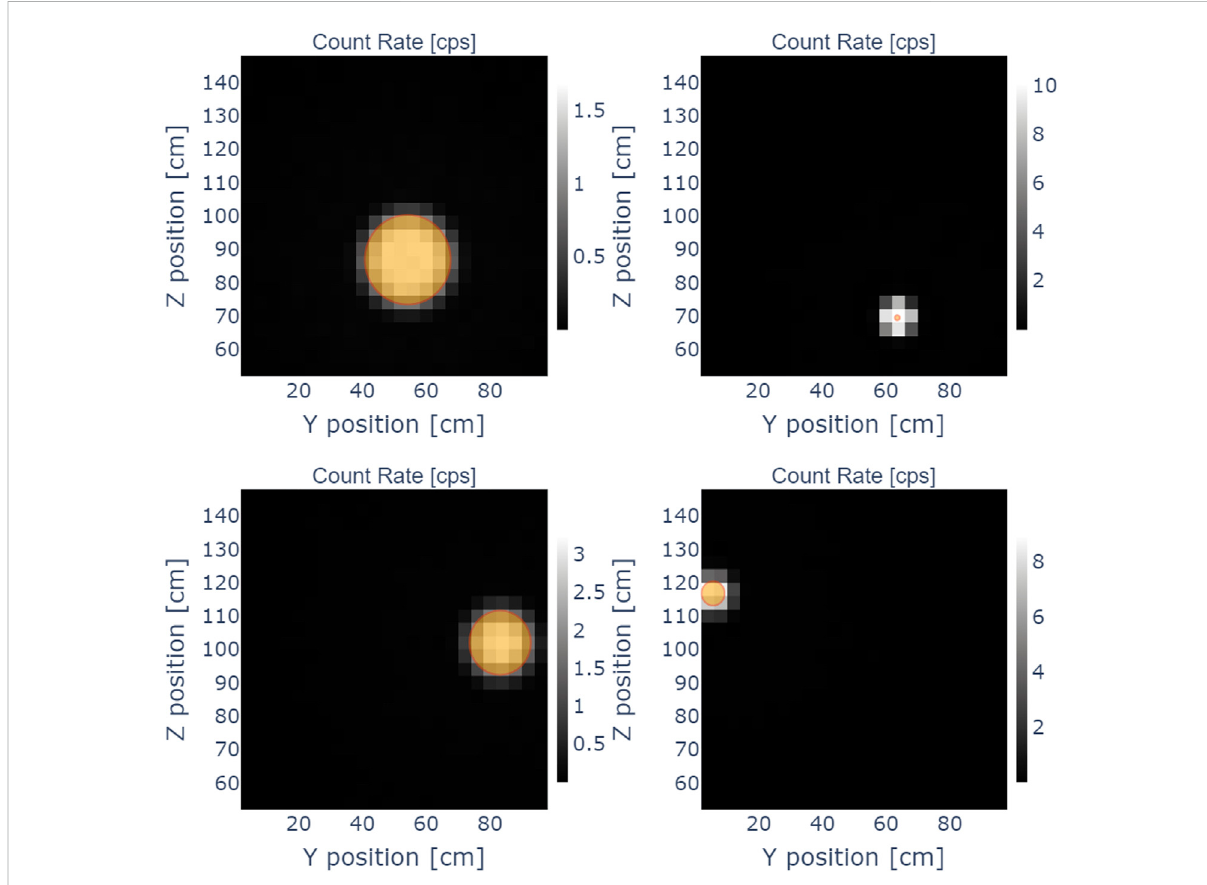
FIGURE 2 Examples of randomly positioned circular sources and their count rates obtained by the MCNP scanning